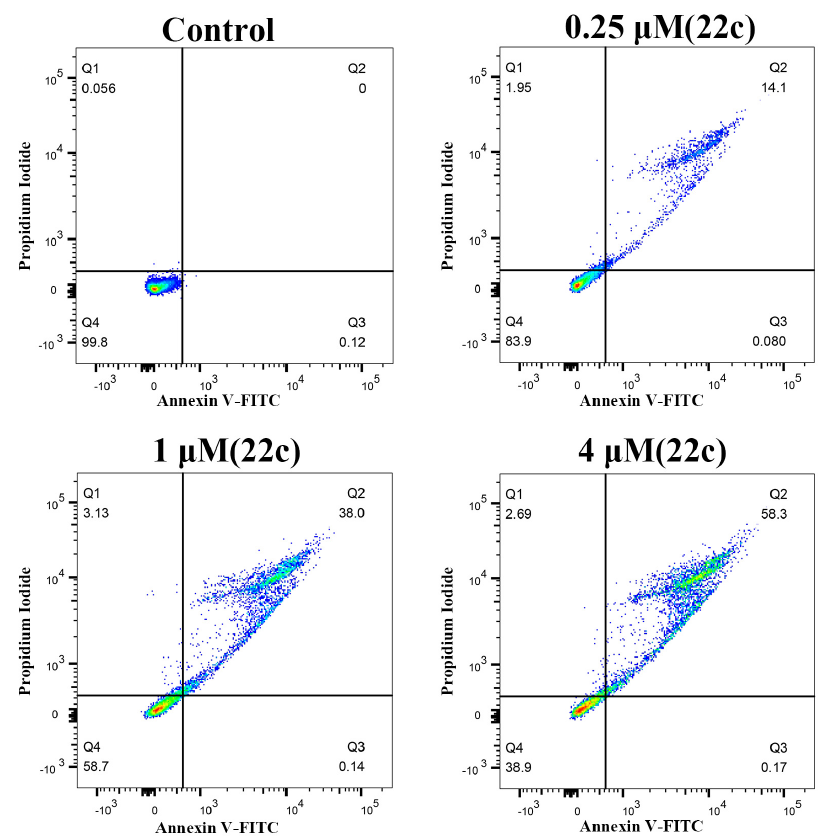
Figure 4. Flow cytometry analysis of apoptosis via Annexin V-FITC/PI staining after treatment with compound 22c at indicated concentrations for 24 h in HCT − 116 cells.